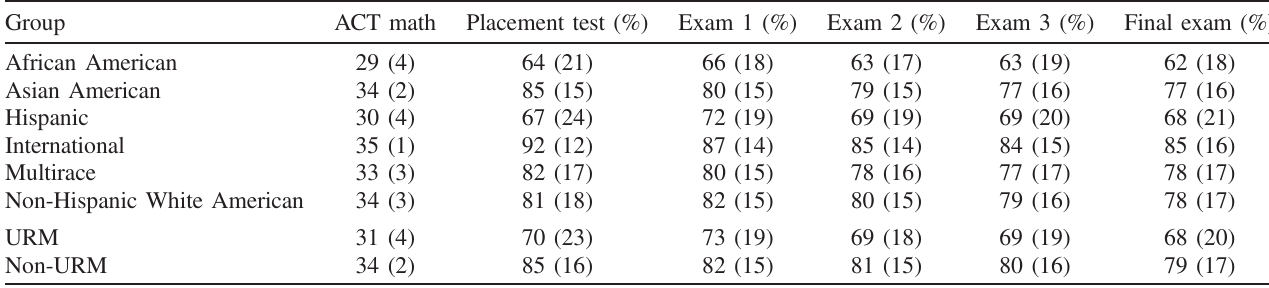
TABLE X. Mean test scores by group, fall data. ACT Math scores are reported as raw scores, whereas the remaining exam scores are reported as percentages. Standard deviations are included in parentheses.